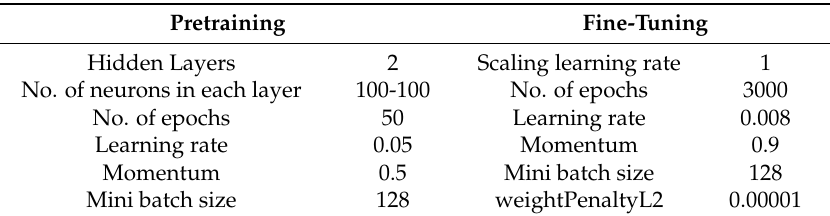
Table 1. Parameters combination